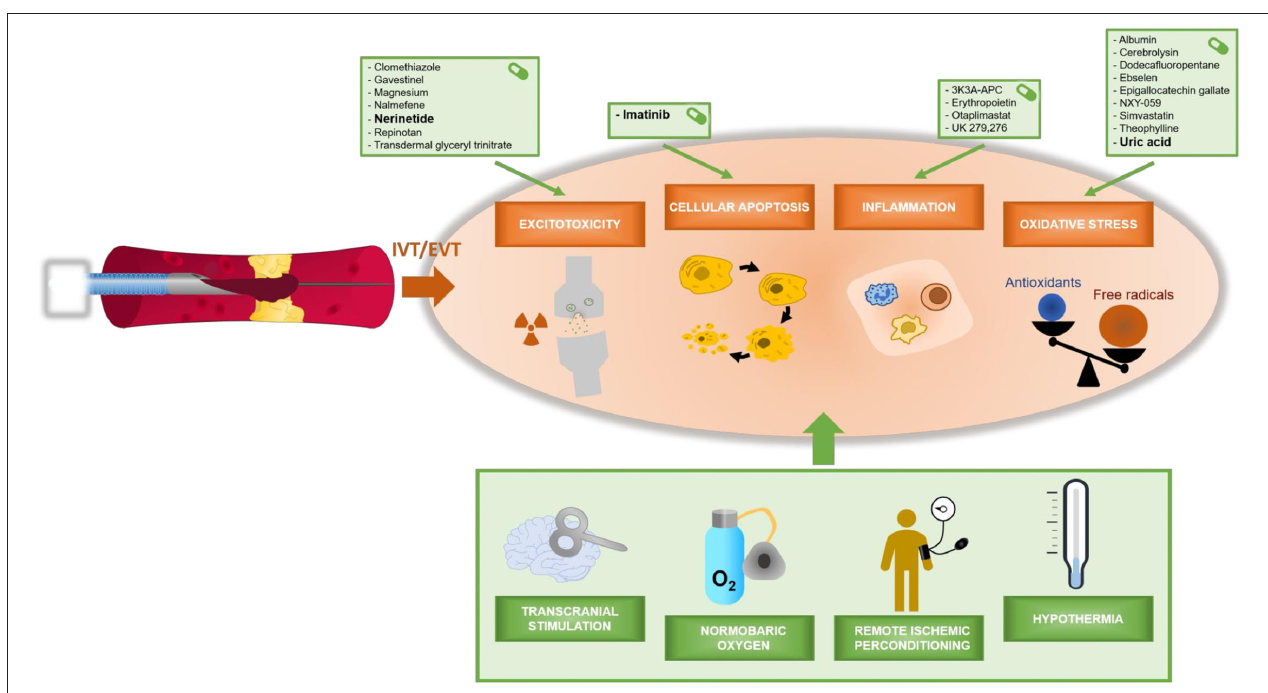
FIGURE 2 | Overview of neuroprotective agents and their assumed mechanisms of